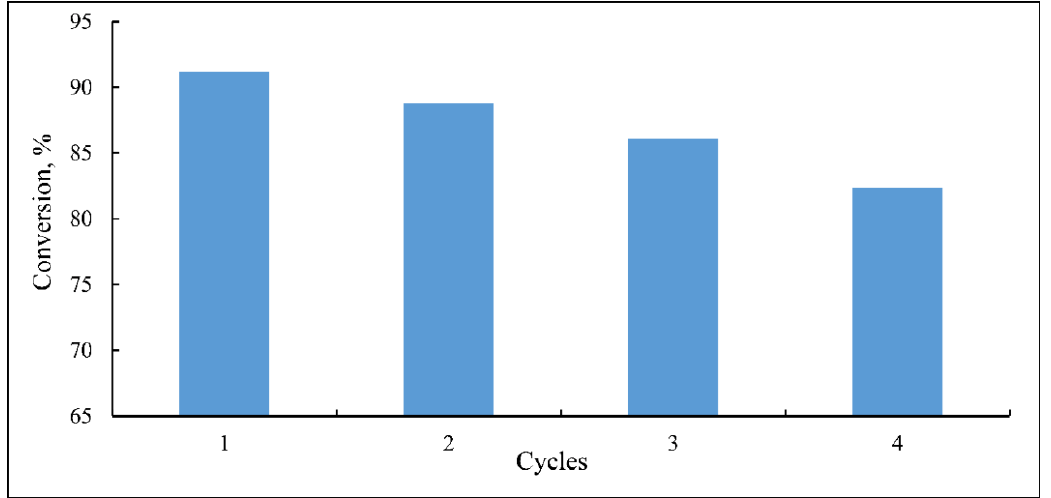
Figure 18. Recyclability of thin film TiO 2 catalyst at the conditions (natural pH, catalyst density 8.72 × 10 − 4 Kg m − 2 , light intensity 9.7 W/m 2 and dye concentration 13 mg/L).